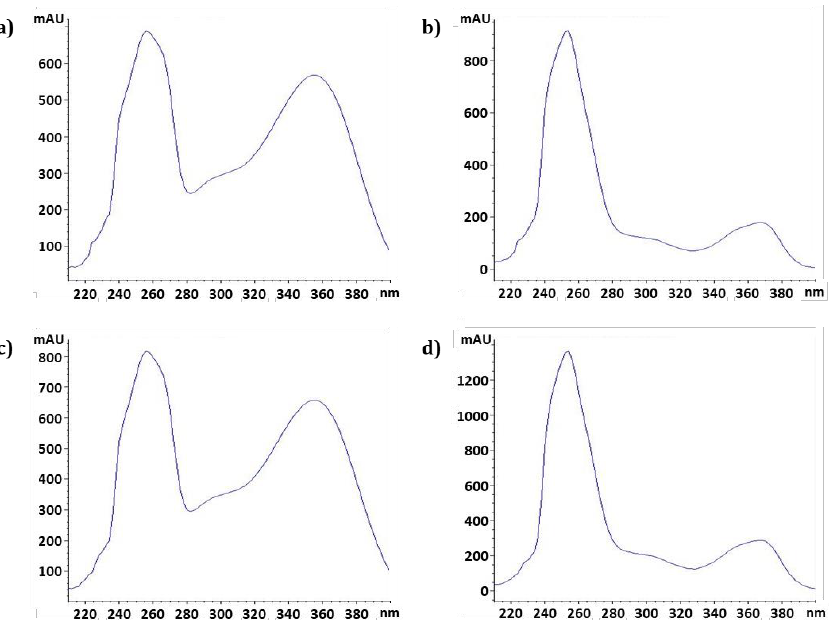
Figure 3. UV spectrum structure of quercetin-3- O -glucuronide and ellagic acid. ( a ) Quercetin-3- O - glucuronide reference; ( b ) Ellagic acid reference; ( c , d ) O. biennis sprout ethanol extract.